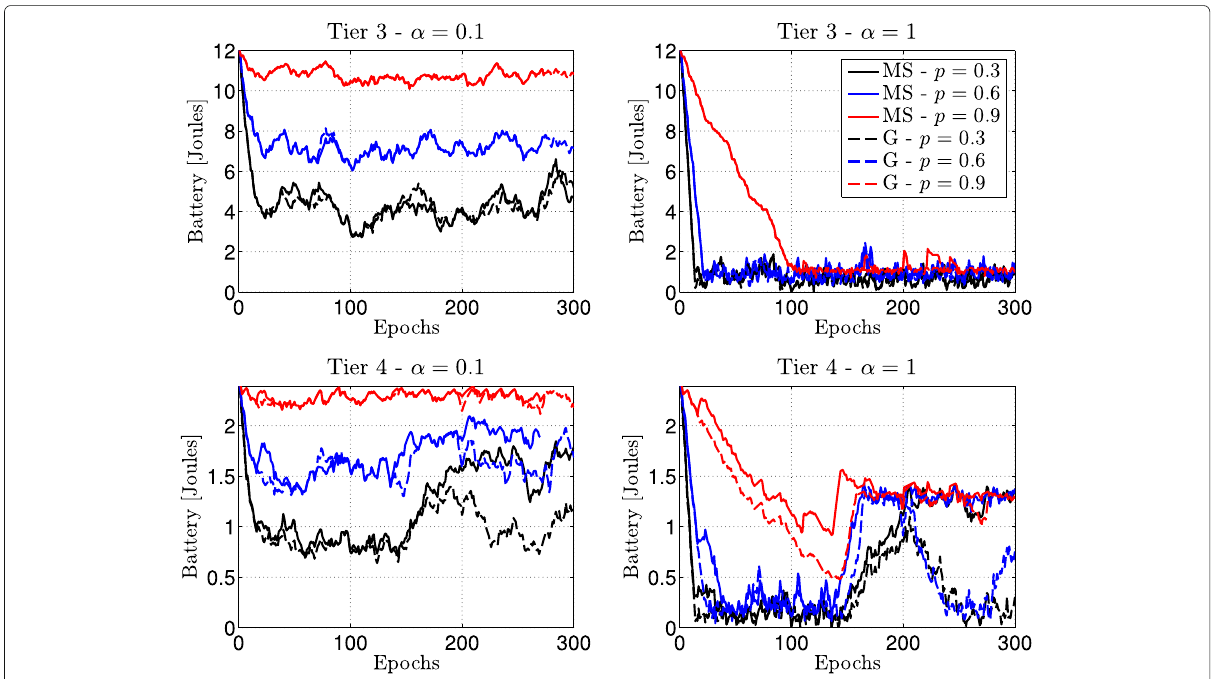
Fig. 7 Average battery evolution (among BSs) of tier 3 and tier 4